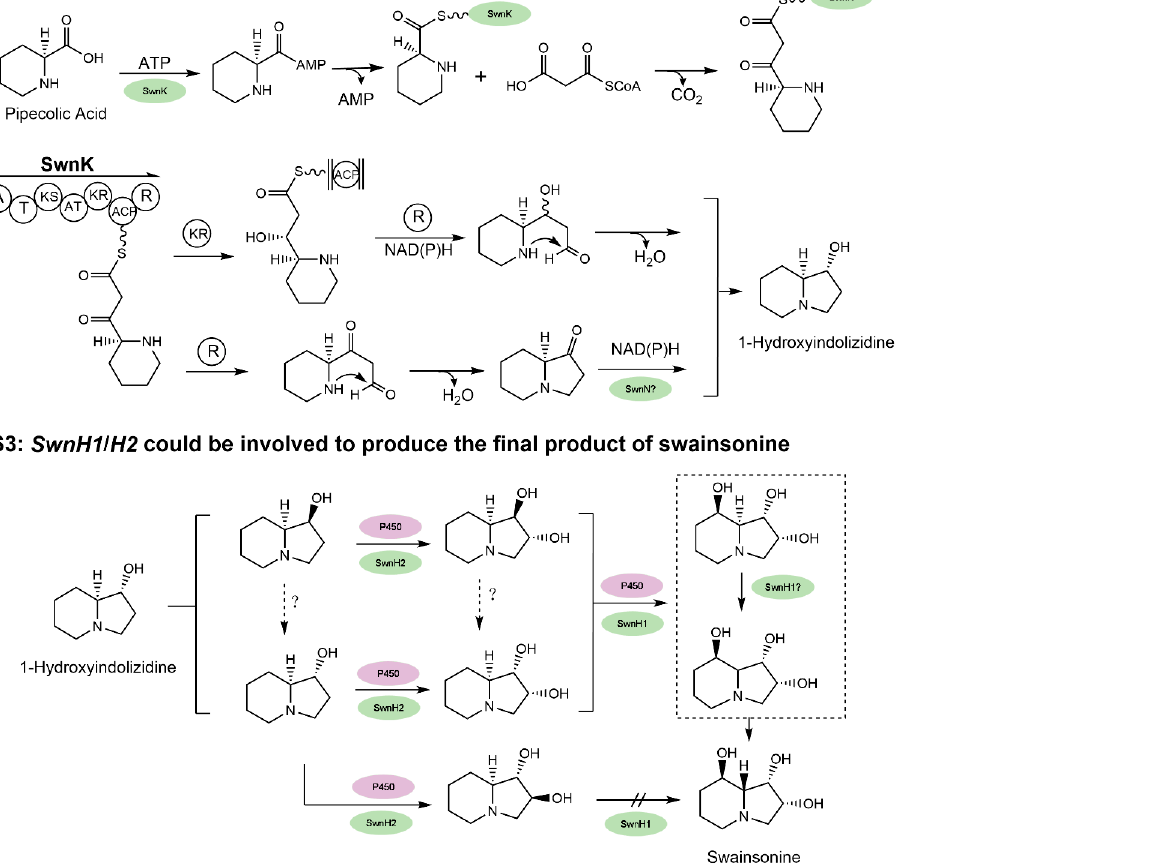
Figure 3. The hypothesized biosynthesis pathway of swainsonine. S1 : The multiple proposed biosynthesis pathways of pipecolic acid (PA). S2 : PA and malonyl Co-A are condensed to form polyketide which is reduced to form cyclic 1-hydroxyindolizinine. S3 : 1-hydroxyindolizinine forms SW after redox reactions. For comparison, genes in purple indicate all the annotated genes with proposed function and position from the locoweed endophytic fungus A. oxytropis , based on its genome sequencing [63]; genes in green represent the proposed and some verified genes in M. robertsii , and “?” indicates that the function and position of activity of the gene still need further characterization [60,61]. Refer to the text for the name of the genes. Certain chemical structures and reactions in the schematics were adapted from previous work by Cook et al. and Luo et al.